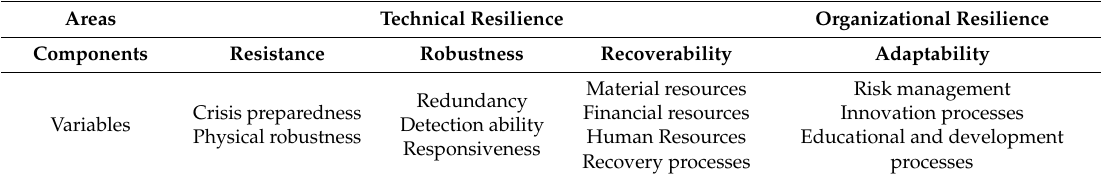
Table 1. Components and variables determining the resilience of critical infrastructure elements (adjusted according to Rehak et al. 2018a).